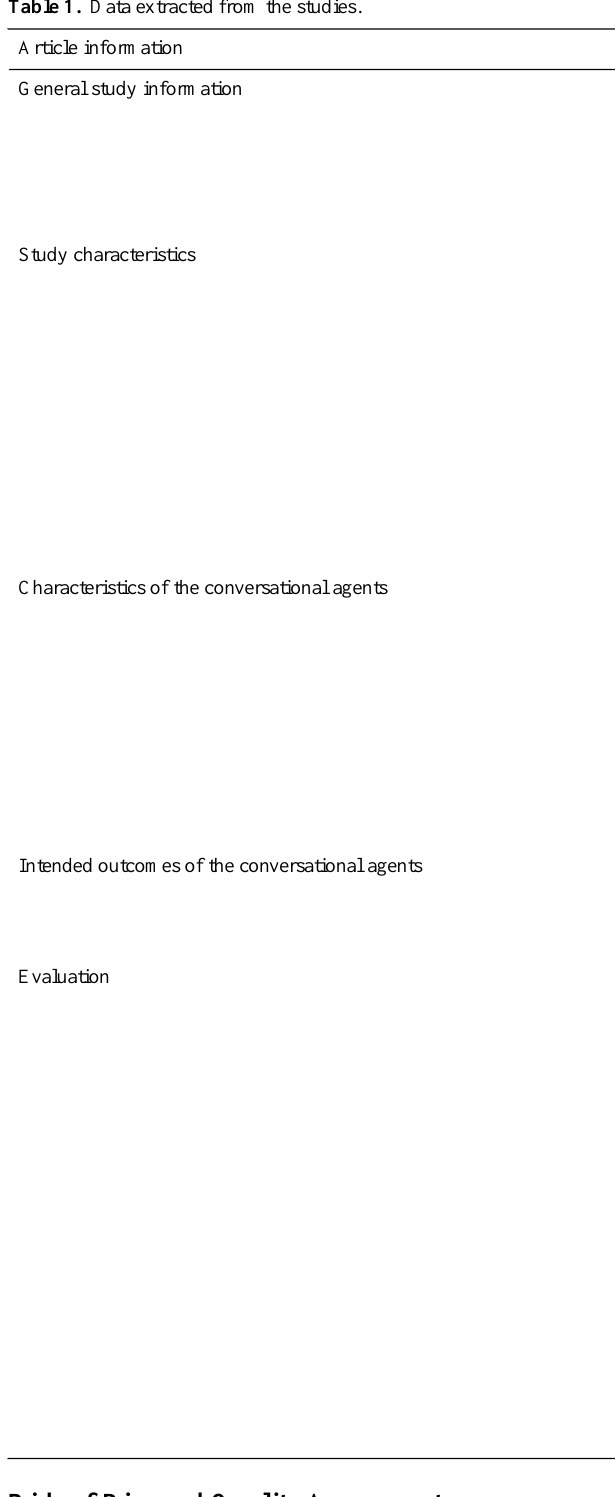
Table 1. Data extracted from the